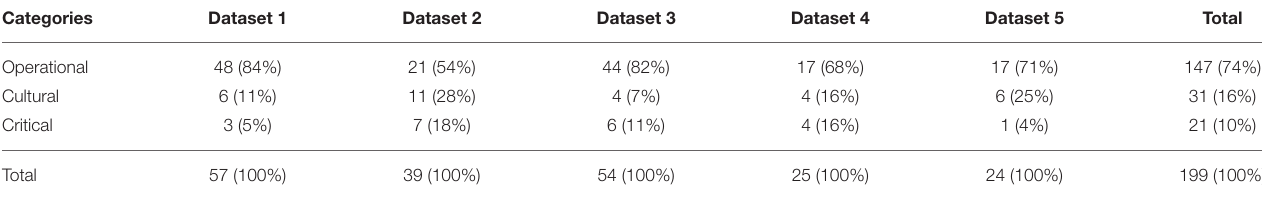
TABLE 4 | Maker literacies across the design challenges and students.